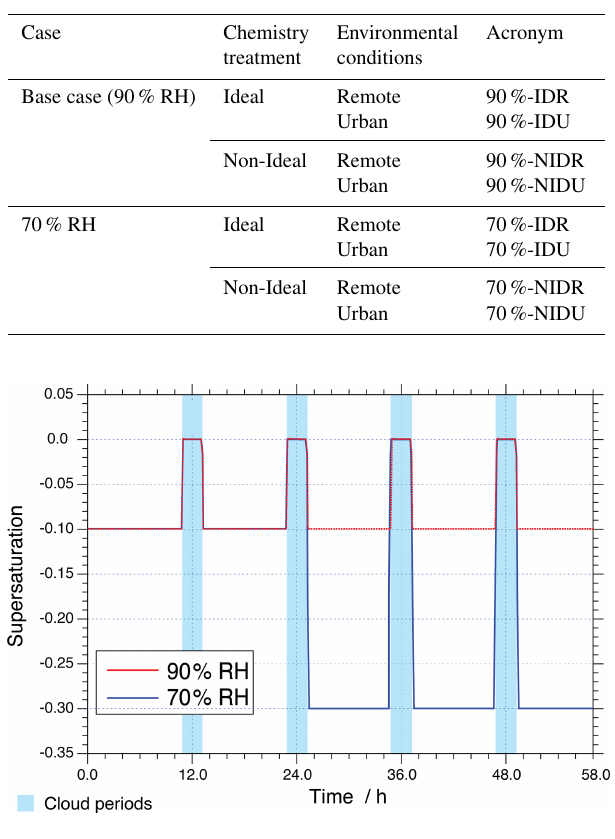
Figure 1. Depiction of the supersaturation along the trajectories of the two different model scenarios with non-cloud periods at 90% and 70% relative